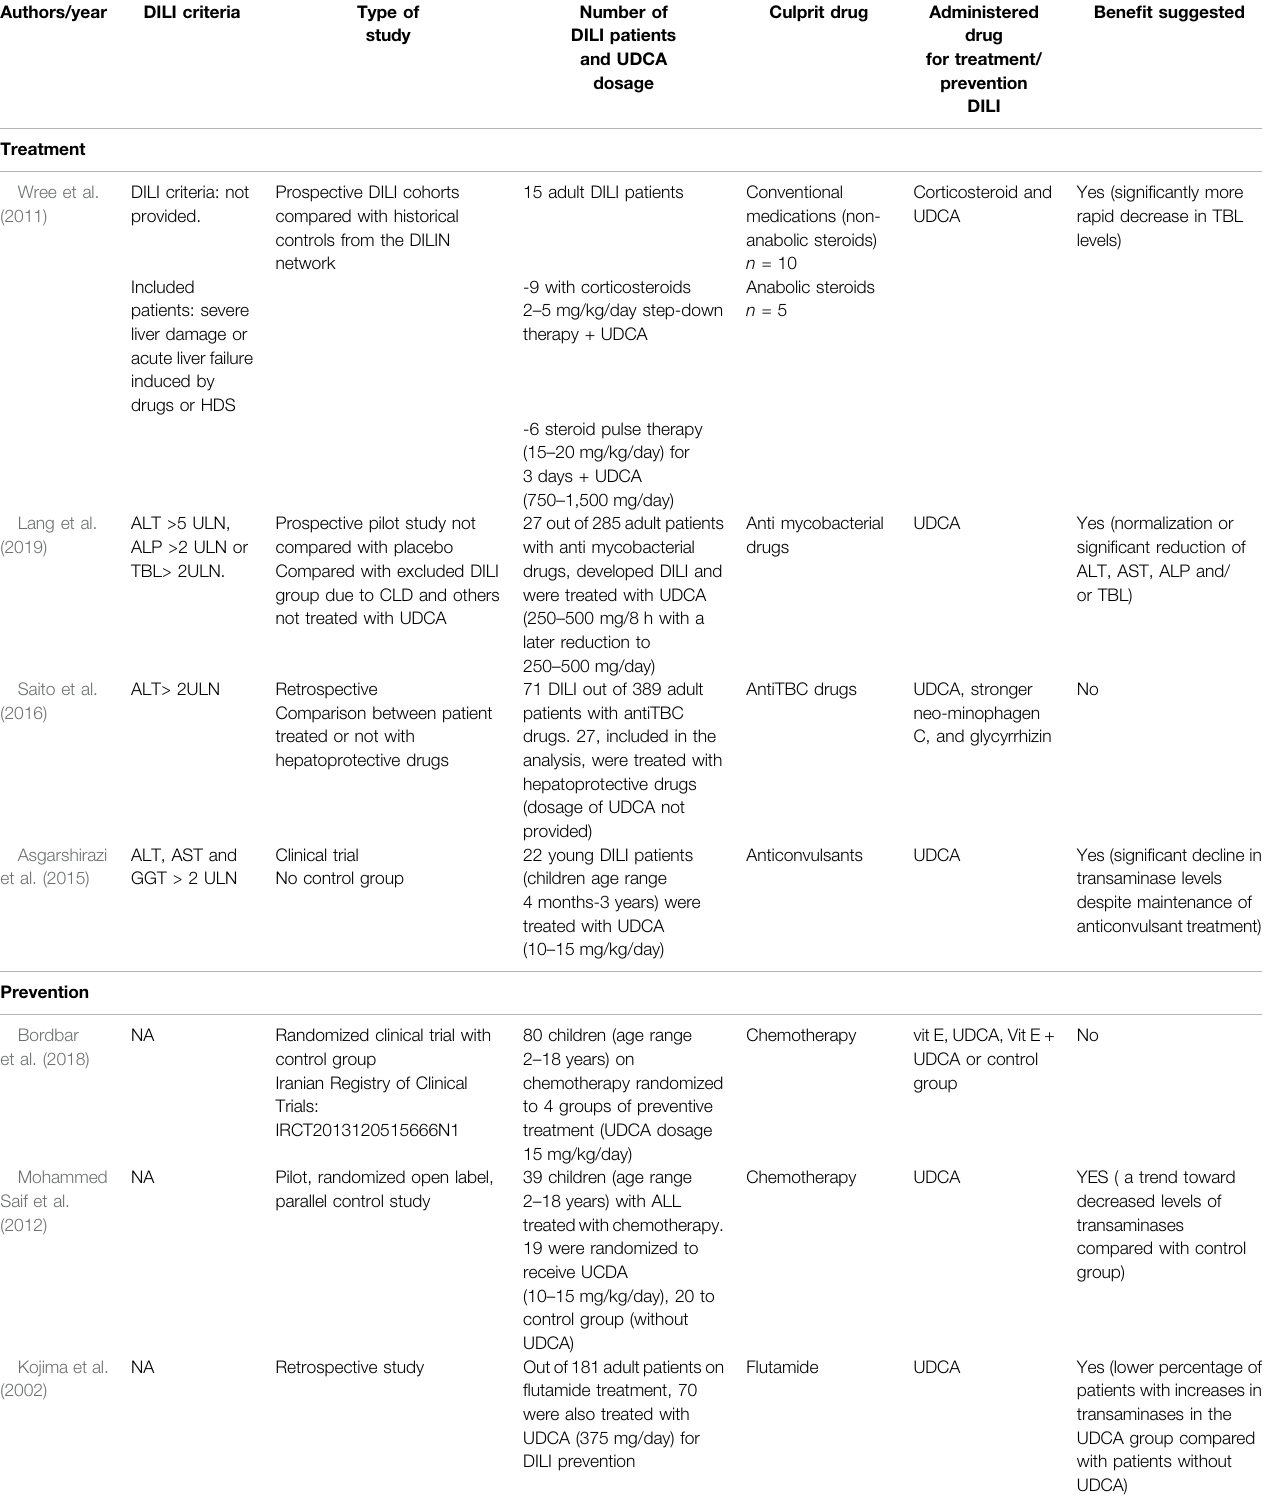
TABLE 2 | Description of prospective and retrospective studies evaluating the role of ursodeoxycholic acid in the treatment and prevention of DILI. Authors/year